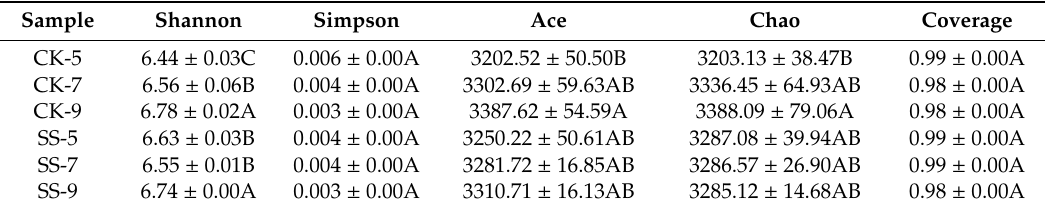
Table 2. Soil α -diversity indices of soil bacteria community in CK-5, CK-7, CK-9, SS-5, SS-7, SS-9. CK: Control, soil of non-infected P. sylvestris var. mongolica ; SS: treatment, soil of infected P. sylvestris var. mongolica ; May, July, and September represent spring, summer, and autumn, respectively. Different letters indicate significant difference at p < 0.05 according to Duncan’s new multiple range test.